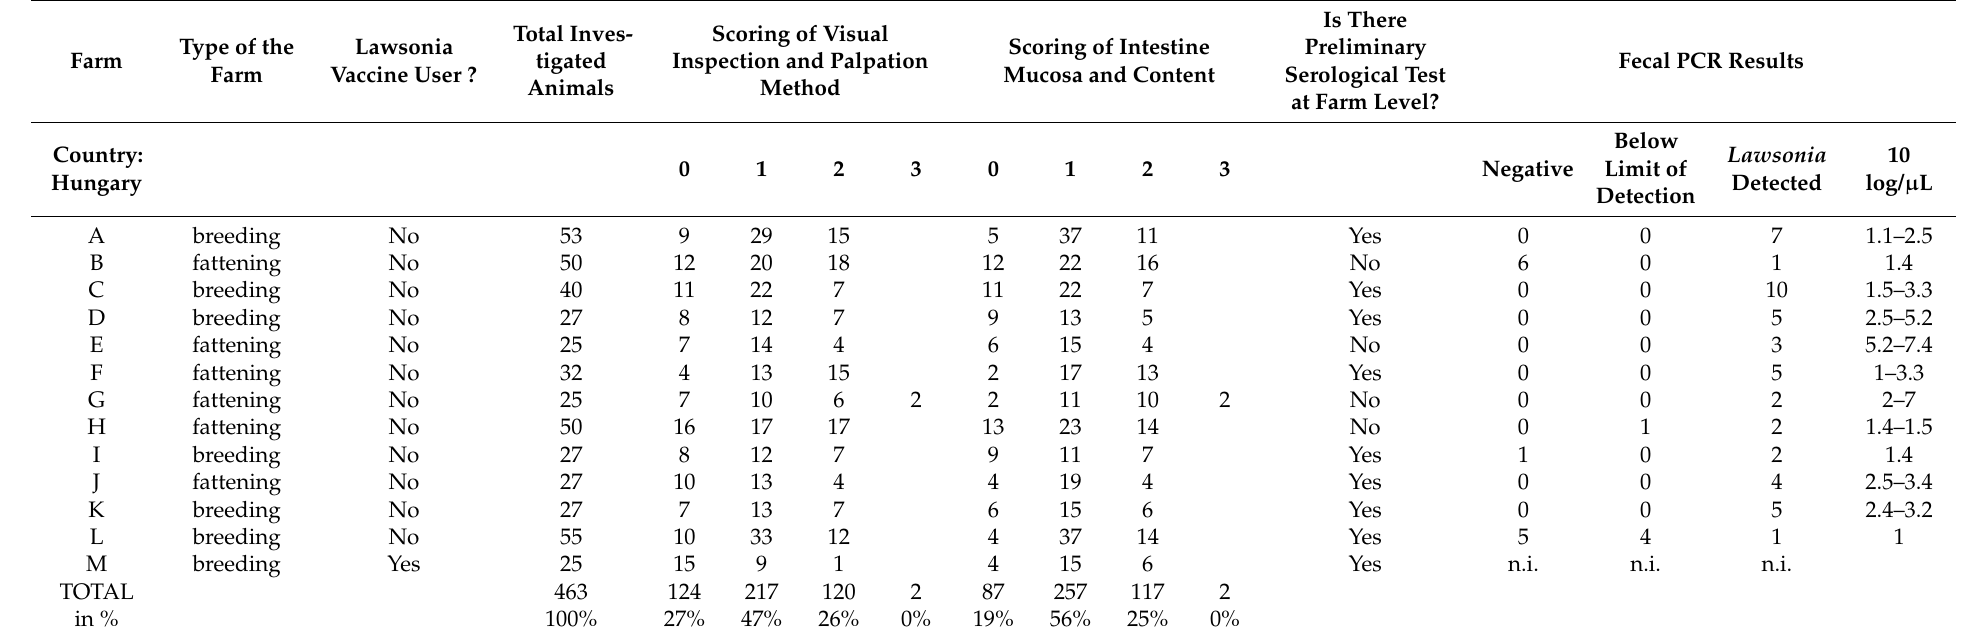
Table 1. VP versus mucosa,